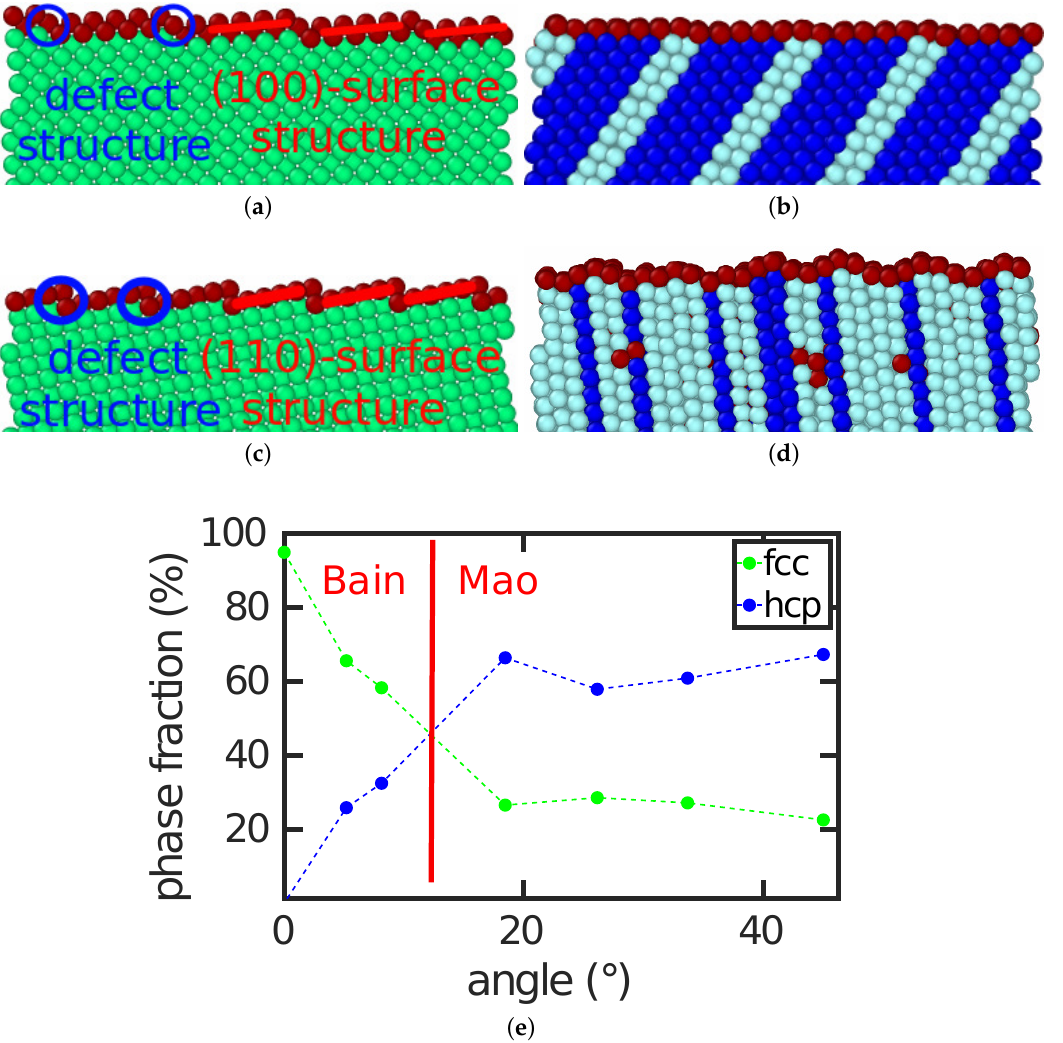
Figure 5. Side view of the thin film with a (11 1 0) bcc surface ( a ) before and ( b ) after the austenitic transformation; and ( c , d ) analogous for the (3 2 0) bcc surface. In the bcc structures ( a , c ), red lines highlight the dominant surface facets— ( 100 ) bcc and ( 110 ) bcc , respectively—while blue circles show the steps. ( e ) The fraction of close-packed phases, fcc and hcp, after the transformation as a function of the tilt angle φ ; the red line separates the regions where the Bain and the Mao path are followed. Colors denote the local lattice structure as in Figure